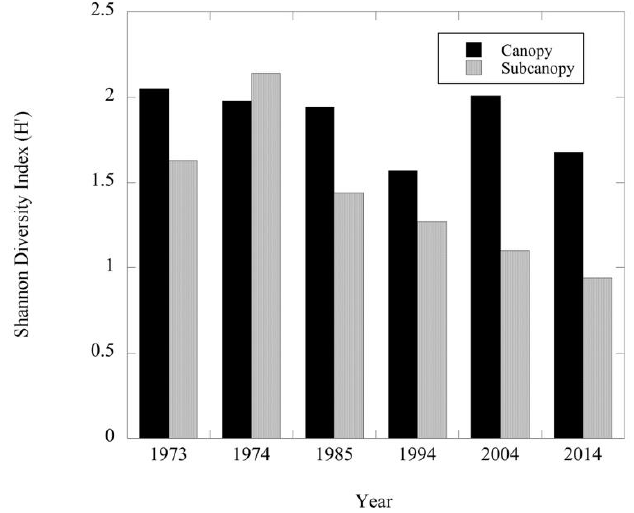
Figure 2. Shannon diversity index values for all canopy (DBH ≥ 30.0 cm) and subcanopy (DBH ≥ 10.0–29.9 cm) tree species recorded at Dinsmore Woods across the six sampling periods.